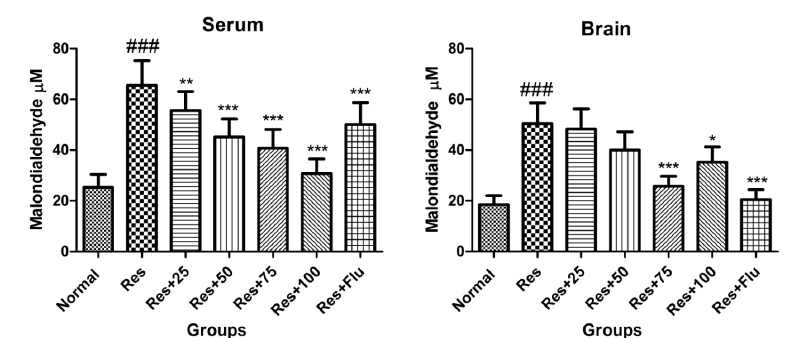
Figure 4. The effect of intraperitoneal injection of different concentrations of Kelussia odoratissima Mozaffarian extract (25, 50, 75, and 100 mg/kg) on the brain and serum MDA levels of mice. Flu= Fluoxetine, Res=reserpine. # Vs. normal group ( ### P < 0.001), *** P < 0.001 * Vs. reserpine-receiving group ( * P < 0.05, ** P < 0.01).